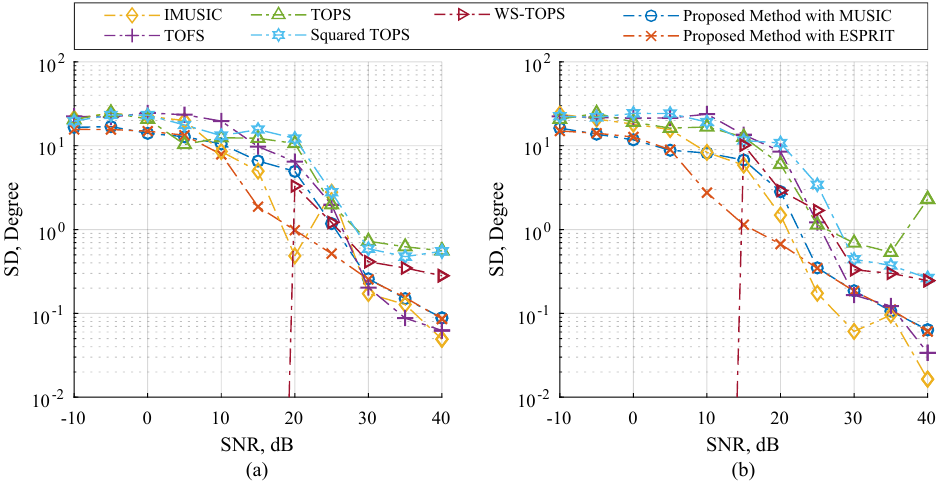
Figure 3. SD estimation performance versus SNR on Scenario 1; ( a ) three different human speeches, and ( b ) three uncorrelated musical sounds where six microphones is employed each